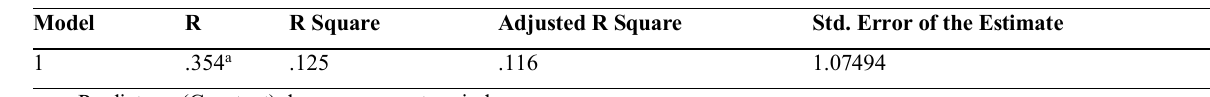
Table 7: Model Summary for Loan Repayment Period Practices